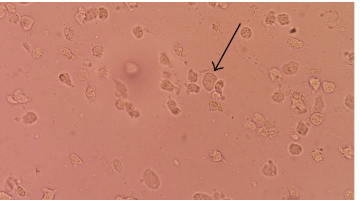
Figure 1: Lophomonas blattarum in direct smear of nasal discharge